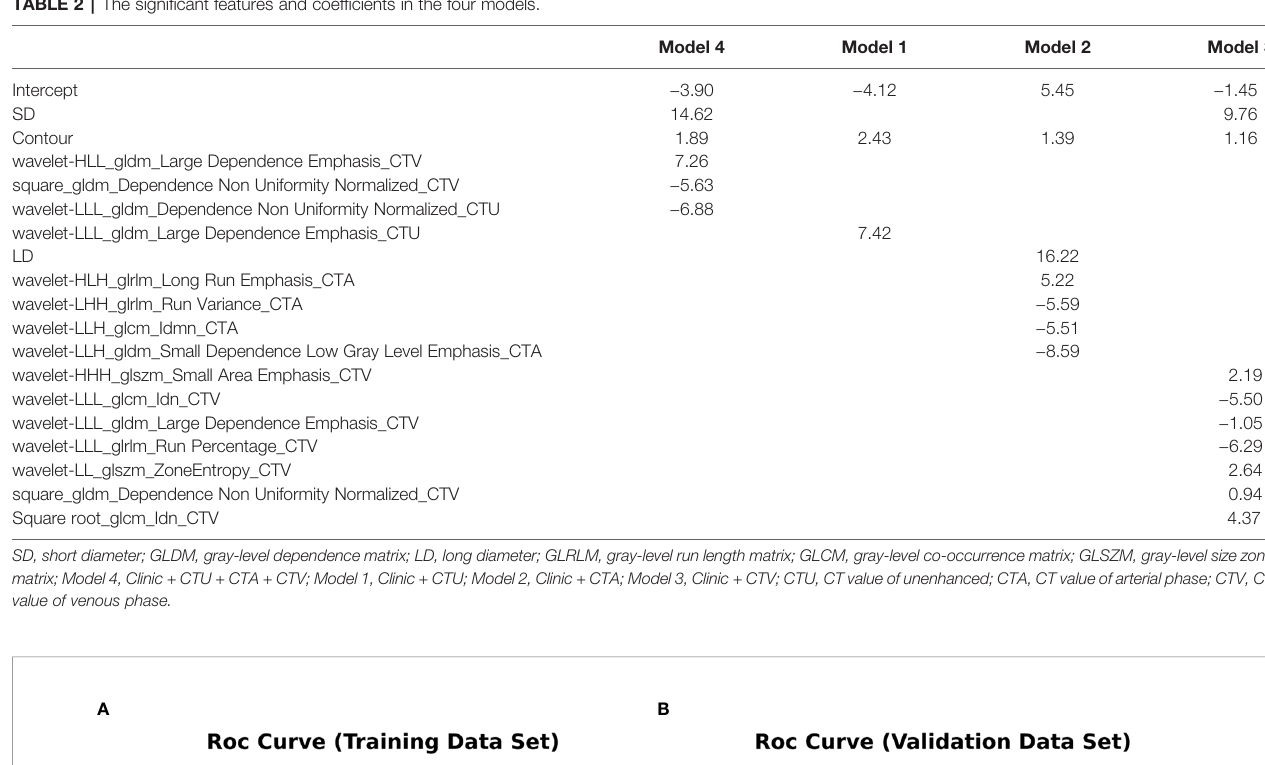
TABLE 2 | The signi fi cant features and coef fi cients in the four